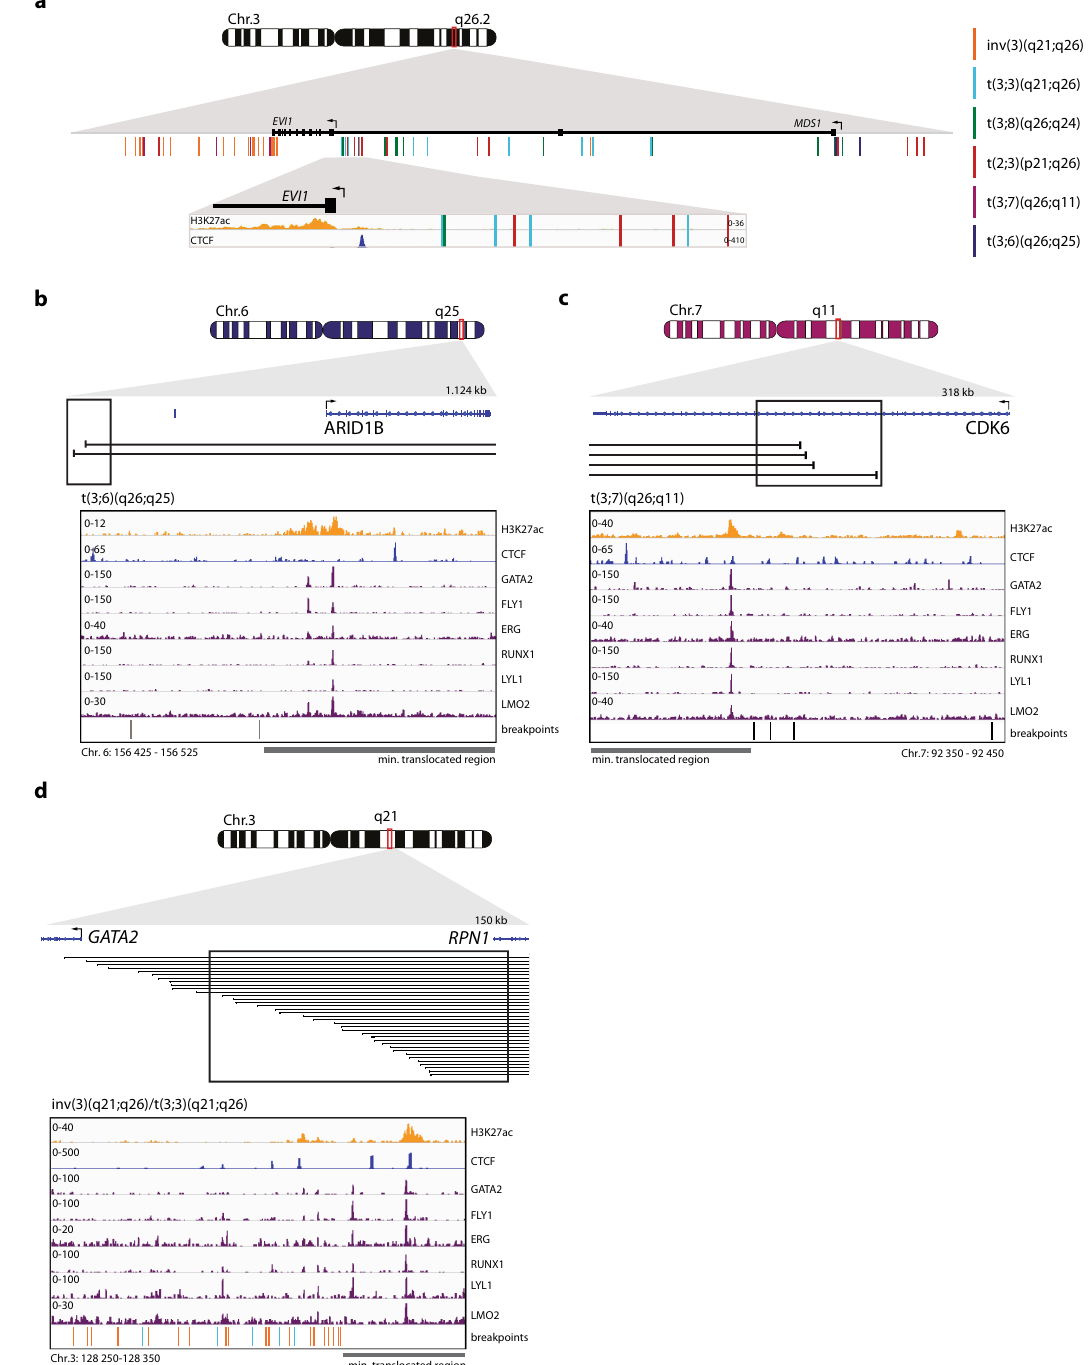
Fig. 7 CTCF enhancer-docking site upstream of the EVI1 promoter is preserved in 3q26-rearranged AML. a Schematic depiction of Chr.3 with a zoom-in on the EVI1 locus, indicating the exact breakpoints (detected by 3q-seq) of 3q26-rearranged AMLs as vertical lines. In the lowest zoom-in panel the EVI1 promoter with a CTCF binding site upstream marked, respectively by H3K27ac (t(3;8) AML-17, orange) and CTCF (K562 t(3;8) clone 24-7, blue) ChIP- seq. b Schematic overview of Chr.6 and the locus where the breakpoints (black lines) were found by 3q-seq in t(3;6)(q26;q25) AML. The black box indicates the area of which the zoom-in is shown below. Zoom-in: putative enhancer indicated by H3K27ac (t(3;8) AML-17, orange), CTCF binding (K562 t(3;8) clone 24-7, blue) and HSPC active transcription factor recruitment (CD43 + cell 29 , purple) at translocation site. The lines below indicate the exact breakpoints. The gray bar the minimal translocated region brought into close proximity of EVI1 in that speci fi c translocation. c Same as b , but here for t(3;7) (q26;q11) AMLs. d Same as b , but here for inv(3)/t(3;3)(q21;q26) AMLs. The exact translocated locus was previously shown to be an enhancer of GATA2 15